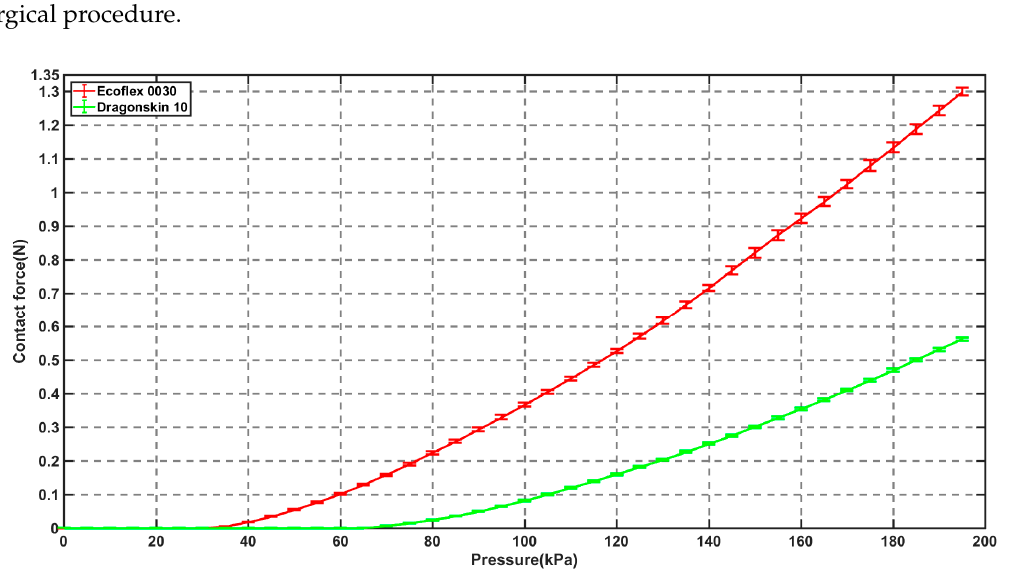
Figure 9. The experimental results for the measurement of the contact force.